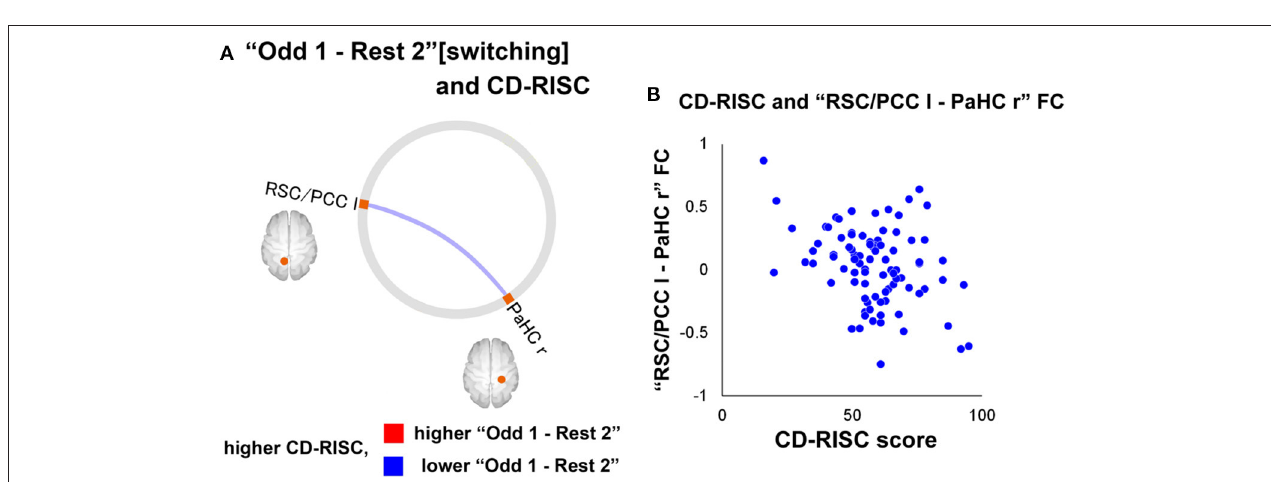
FIGURE 8 | (A) A significant correlation between CD-RISC scores and the FC changes at “switching” phase. The blue line indicates that there was a negative correlation between the value for the “Odd 1–Rest 2” period and CD-RISC scores. (B) Scatterplot of the relationship between CD-RISC scores and the “RSC/PCC l-PaHC r” FC for “Odd 1–Rest 2”. CD-RISC, connor–davidson resilience scale; DMN, default mode network; ROI, region of interest; r, right; l, left; lr, left and right; PCC, posterior cingulate cortex; PaHC, parahippocampal cortex; RSC, retrosplenial cortex [Revised from Miyagi et al.